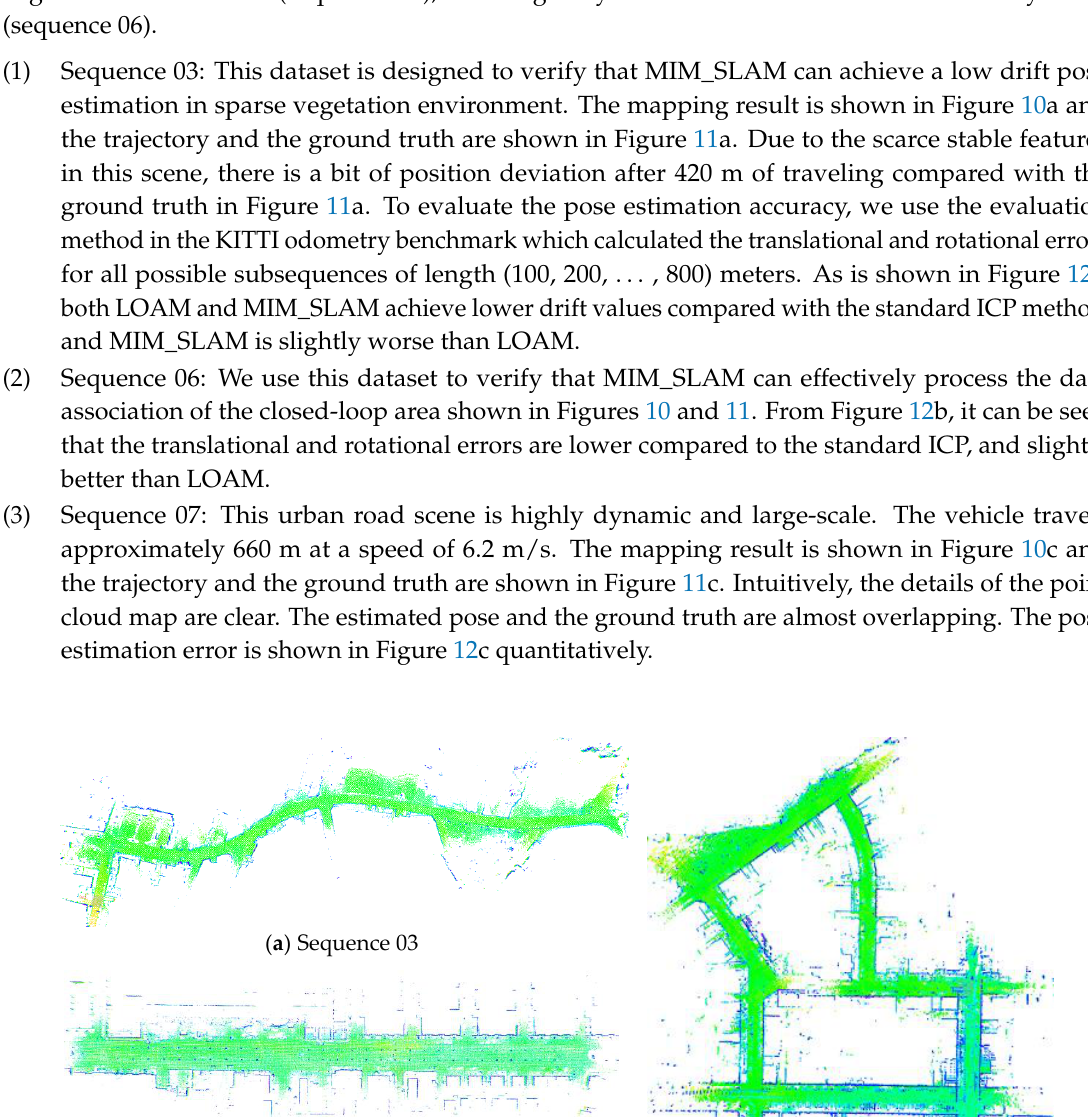
Table 2. The average time consumption per frame for different approaches/scenes.